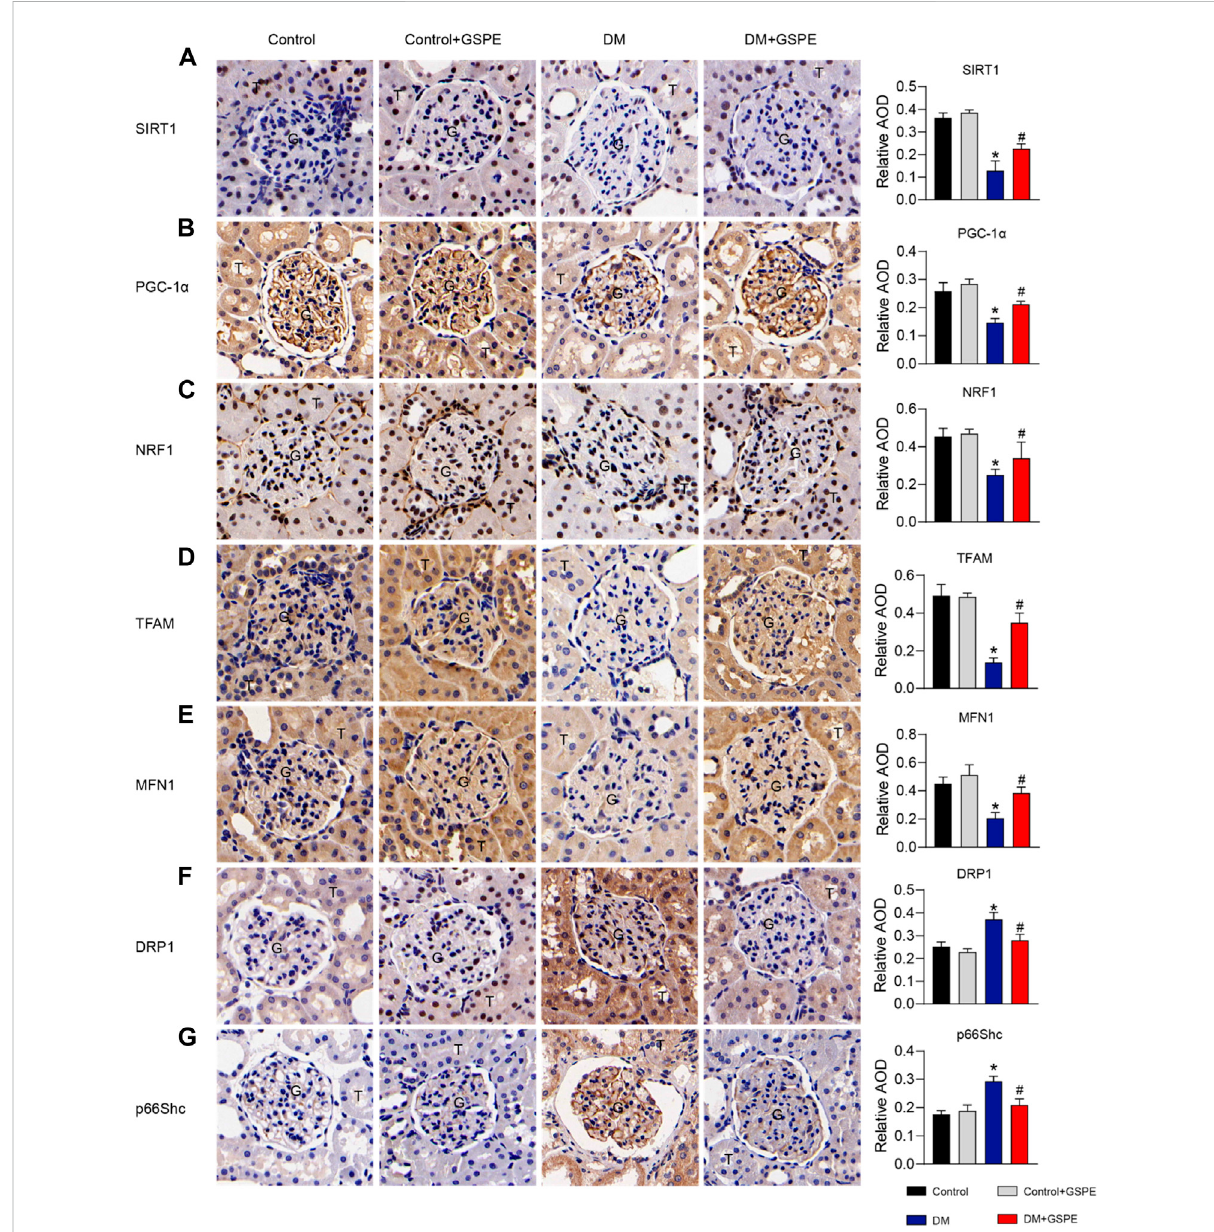
FIGURE 5 Immunohistochemistry delineated the localization and changes in the expression of proteins and quanti fi cation of relative AOD in each group. (A) SIRT1 is expressed in the nuclei of renal tubules. (B) PGC-1 α is expressed in the cytoplasm of renal glomeruli and tubules. (C) NRF1 is expressed in the nuclei of renal tubules and partly glomeruli. (D) TFAM is expressed in the cytoplasm of renal glomeruli and tubules. (E) MFN1 is expressed in the cytoplasm of renal glomeruli and tubules. (F) DRP1 is expressed in the cytoplasm of renal tubules and partly glomeruli. (G) P66Shcisexpressedinthecytoplasmofglomeruliandsometubules.Scalebars:50 μ m.Originalmagni fi cation,×200.Mean±SD.n=6. p p < 0.05vs. control; # p < 0.05 vs. DM group. G: glomeruli. T: